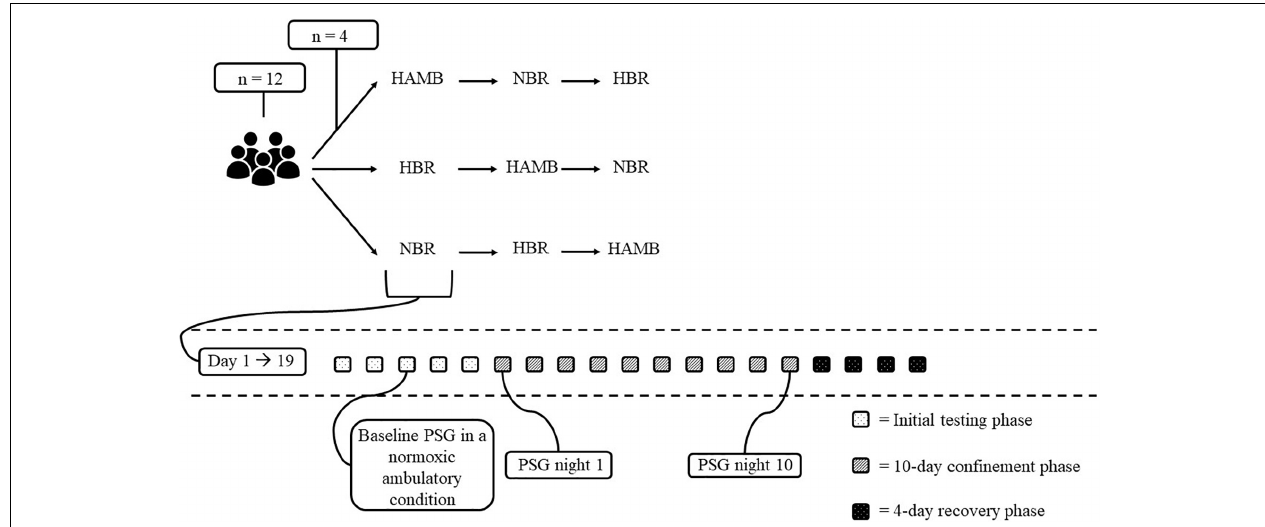
FIGURE 1 | Overview of the experimental design. HAMB, normobaric hypoxic ambulatory; NBR, normobaric normoxic BR; HBR, normobaric hypoxic BR. The baseline PSG in a normobaric normoxic ambulatory condition (i.e., pNAMB) was performed once in the initial testing phase of one of the three conditions (i.e., HAMB, NBR, or HBR). For all participants the baseline PSG recording was performed before the